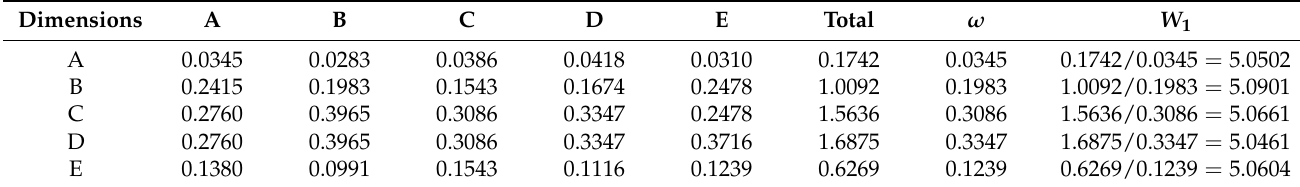
Table 8. The calculation of maximum eigenvalue for five